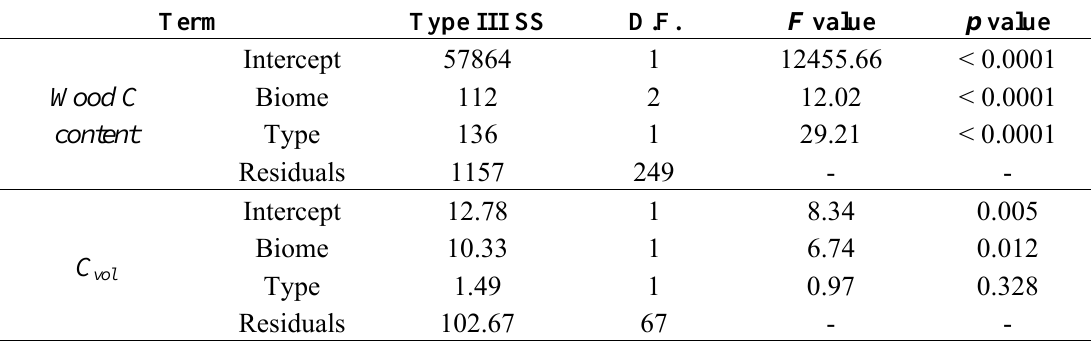
Table 3. Analysis of variance for wood C content and the volatile C fraction (C function of biome (tropical, subtropical/Mediterranean, temperate/boreal) and type (conifer, angiosperm).